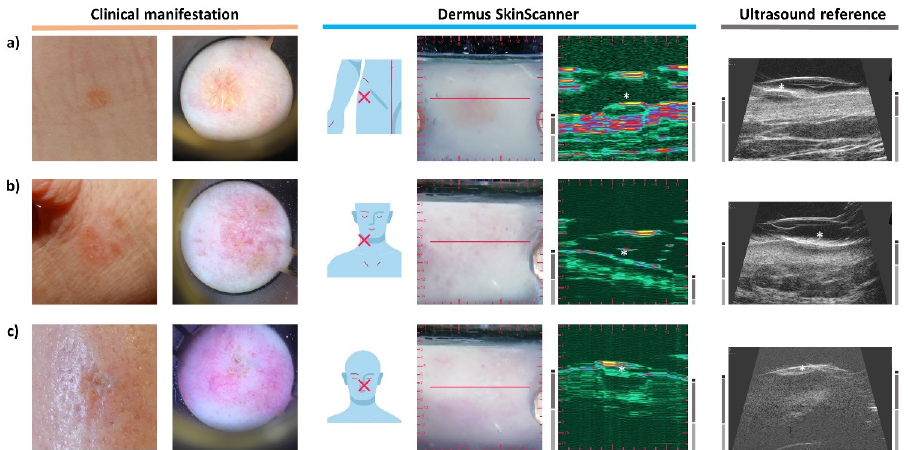
Figure 5. Examination images of basal cell carcinomas (BCC) (see Figure 2 for figure layout and marking information). ( a ) A slightly elevated BCC. The ultrasound images show a relatively hypoechoic (with echoes from inside), compact, but asymmetric lesion. The dermal region of this example is more hyperechoic than those shown in Figure 4; this represents the variability of skin echogenicity between patients and body locations. ( b ) A clinically flat, erythematosus BCC that was treated with cryotherapy one year before the examination. The ultrasound images show a relatively hypoechoic lesion with hypoechoic boundary regions. ( c ) A slightly sunken, scaly BCC that was treated with electrocautery therapy 3 months before the examination, being present in a location at which it is relatively hard to perform ultrasound imaging. The ultrasound images show a heterogeneously hypoechoic lesion with border irregularities.